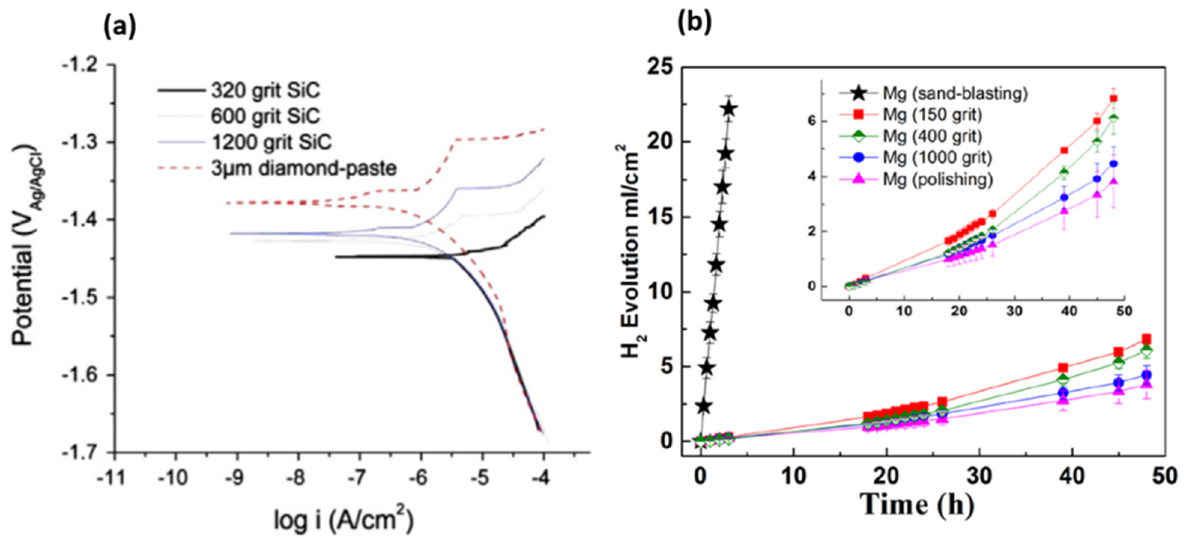
Figure 1. ( a ) Potentiodynamic polarization curves of the AZ91 alloy, with different surface roughness, tested in 0.5 wt.% NaCl [9]. ( b ) Hydrogen evolution of the pretreated AZ91 alloy in 3.5 wt. % NaCl solution [13]. Reprinted from [9] and [13] with permission from Elsevier.